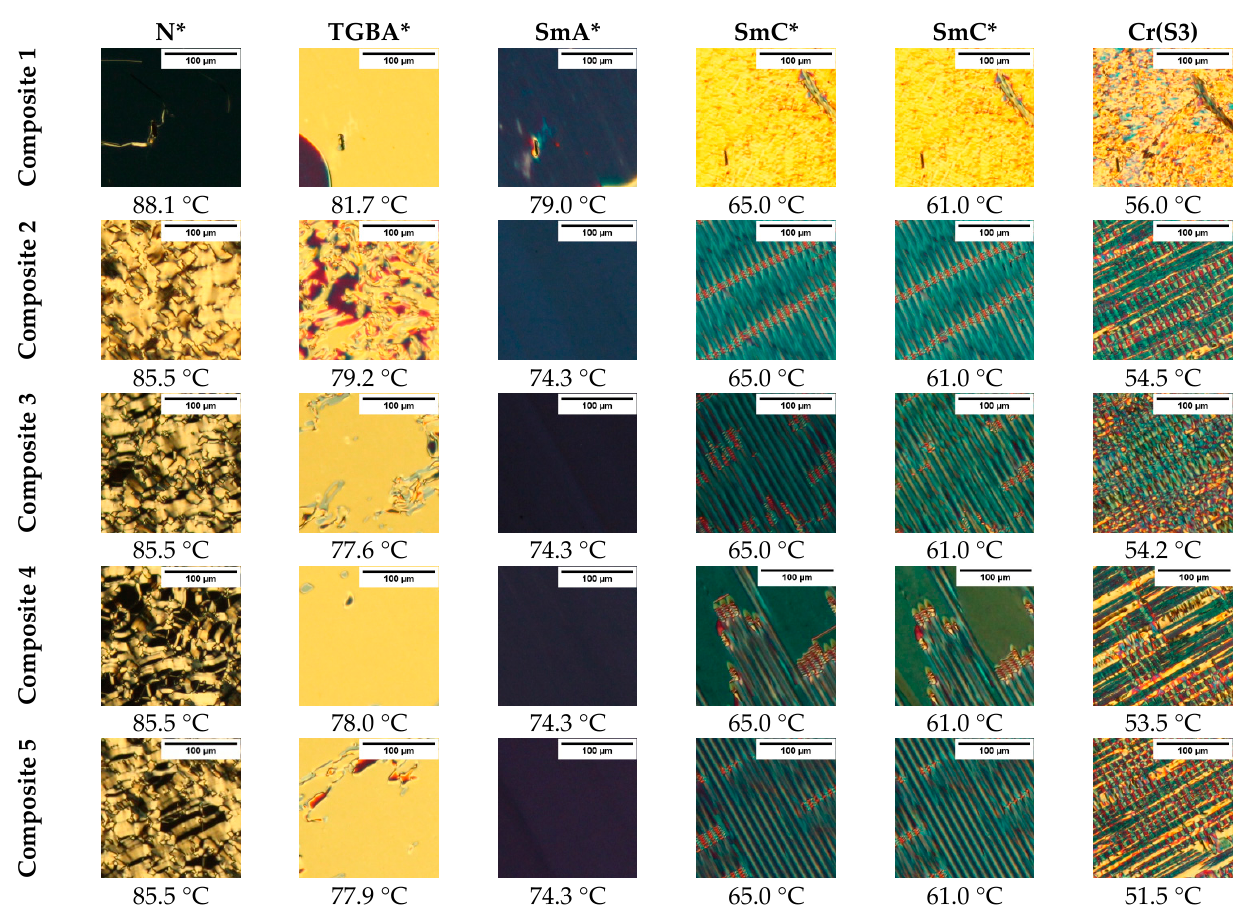
Figure 7. Textures of Composites 1–5 registered during cooling (2 °C/min) at the same light intensity. The last column represents the first observed crystalline phase. The textures within each composite represent the same area.